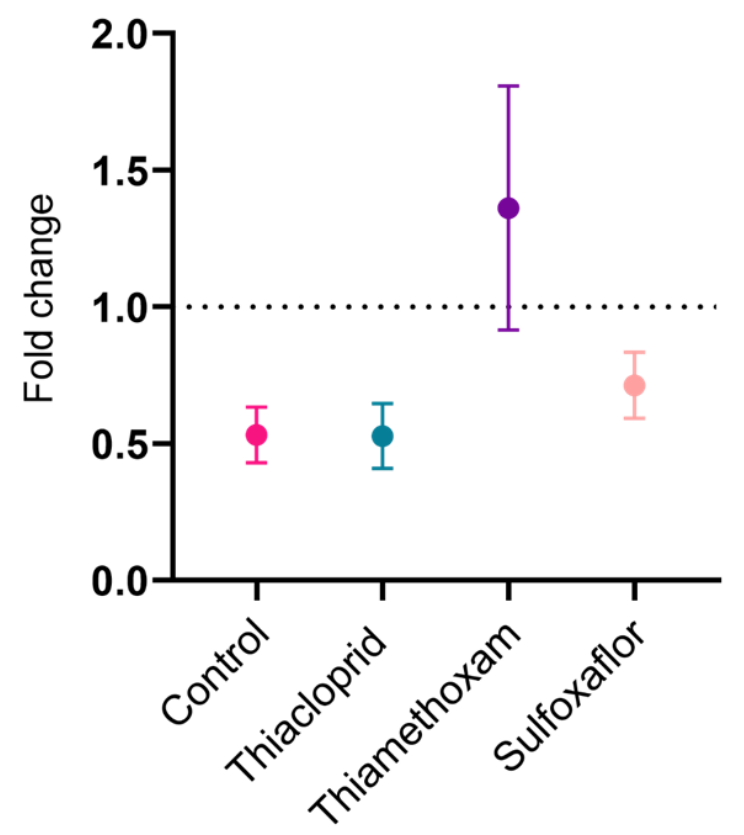
Figure 6. Bee speed fold change pre- versus post-training in the lower concentration trials ( ± SEM). Fold change calculated by dividing speed post-training by speed pre-training for individual bees. Control n = 9, thiacloprid n = 9, thiamethoxam n = 9, sulfoxaflor n = 9.